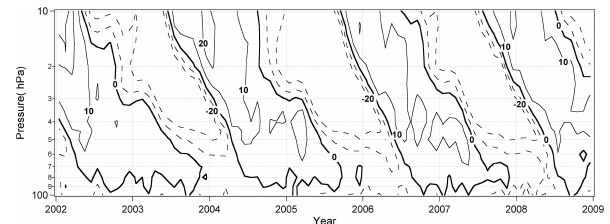
Fig. 1. Time-height section of the equatorial QBO wind updated from Naujokat (1986). Easterly wind contours (negative values) are plotted with dashed